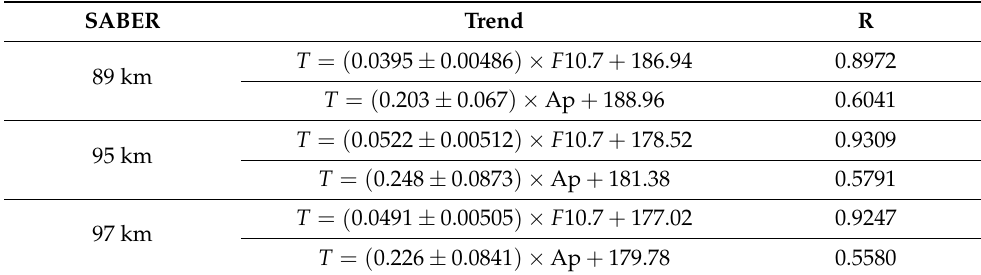
Figure 6. Zonal mean annual average of SABER temperature at 18° N at 97 km. ( a ) Time series of temperature (blue line with dots), F10.7 (red line), and Ap index (brown dashed line). ( b ) Trend analysis of temperature as a function of the F10.7 (red line and dots) and of the Ap index (brown dashed line and triangles). Table 2. F10.7 and Ap index trends with correlation coefficient R obtained from the zonal mean SABER temperature measurements.